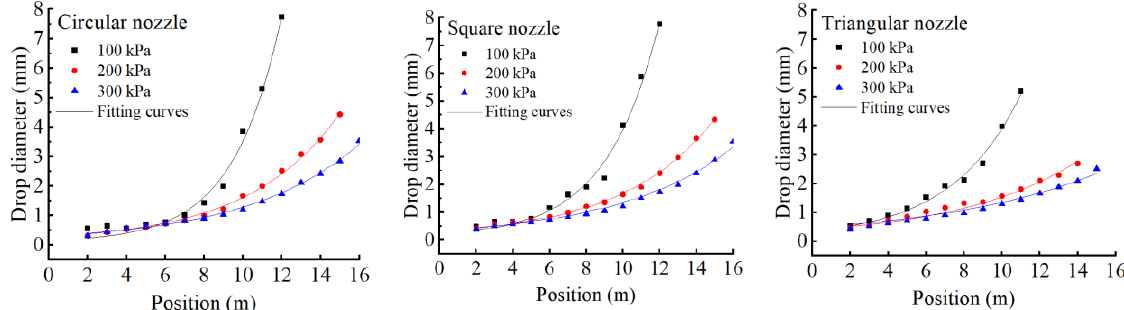
Figure 5. The exponential relationship between droplet size and orifice shapes. Table 2. Exponential relationships between the droplet diameter and distance for different nozzles. Orifice Shape C s